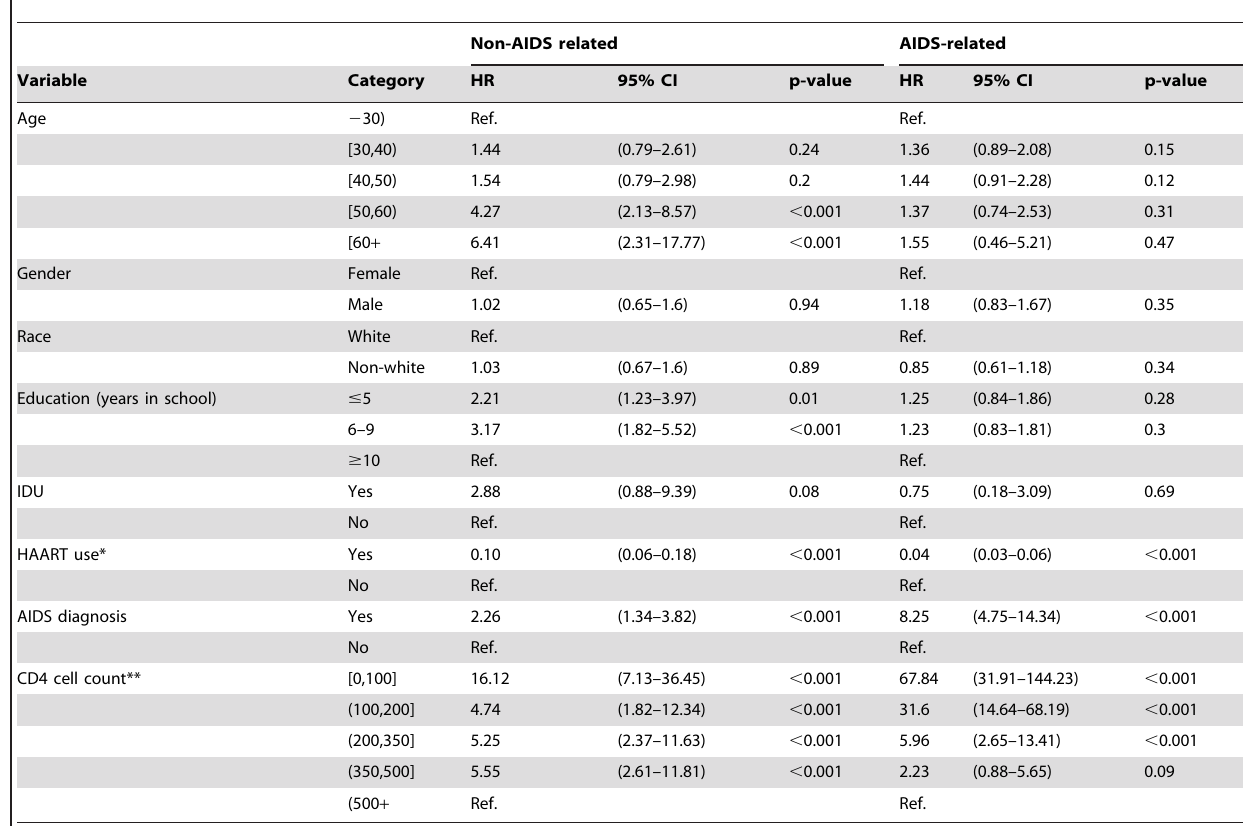
Table 4. Adjusted hazard ratios (HR) and 95% confidence intervals (95%CI) for factors associated with non-AIDS-related and AIDS- related causes of death estimated using extended Cox proportional hazards models, accounting for competing